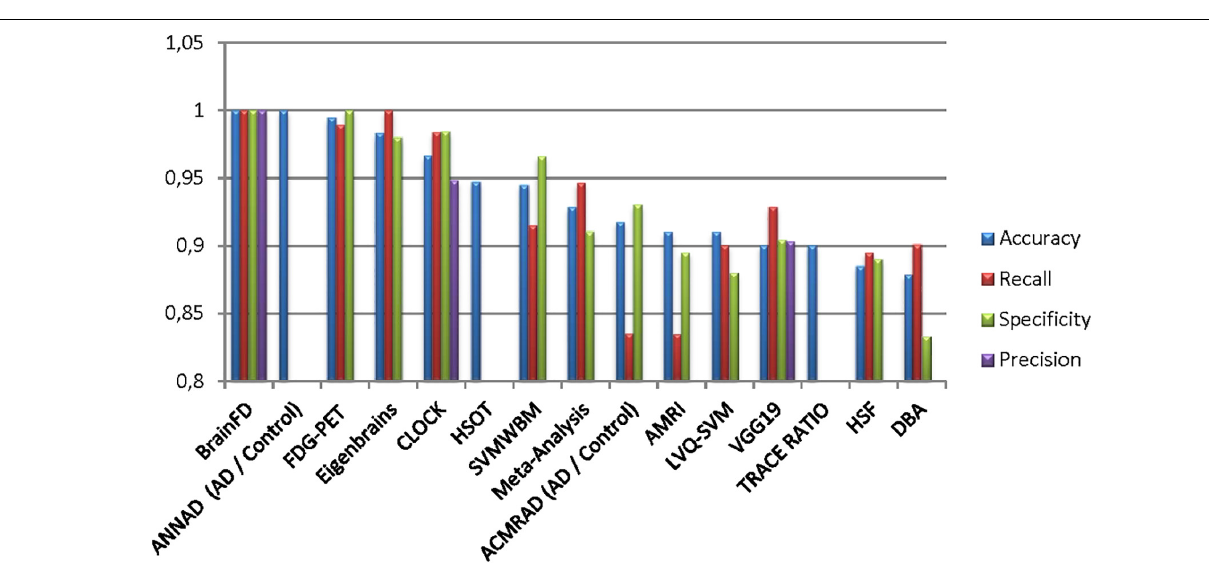
FIGURE 20 | Comparison of the current classification (BrainFD) with other methods. Each compared method corresponds to the following bibliography, respectively (Huang et al., 2008; Kloppel et al., 2008; Magnin et al., 2009; Desikan et al., 2009; Lopez, 2009; Ortiz et al., 2013; Dukart et al., 2013; Yong et al., 2014; Bharanidharan and Rajaguru, 2018; Chen et al.,